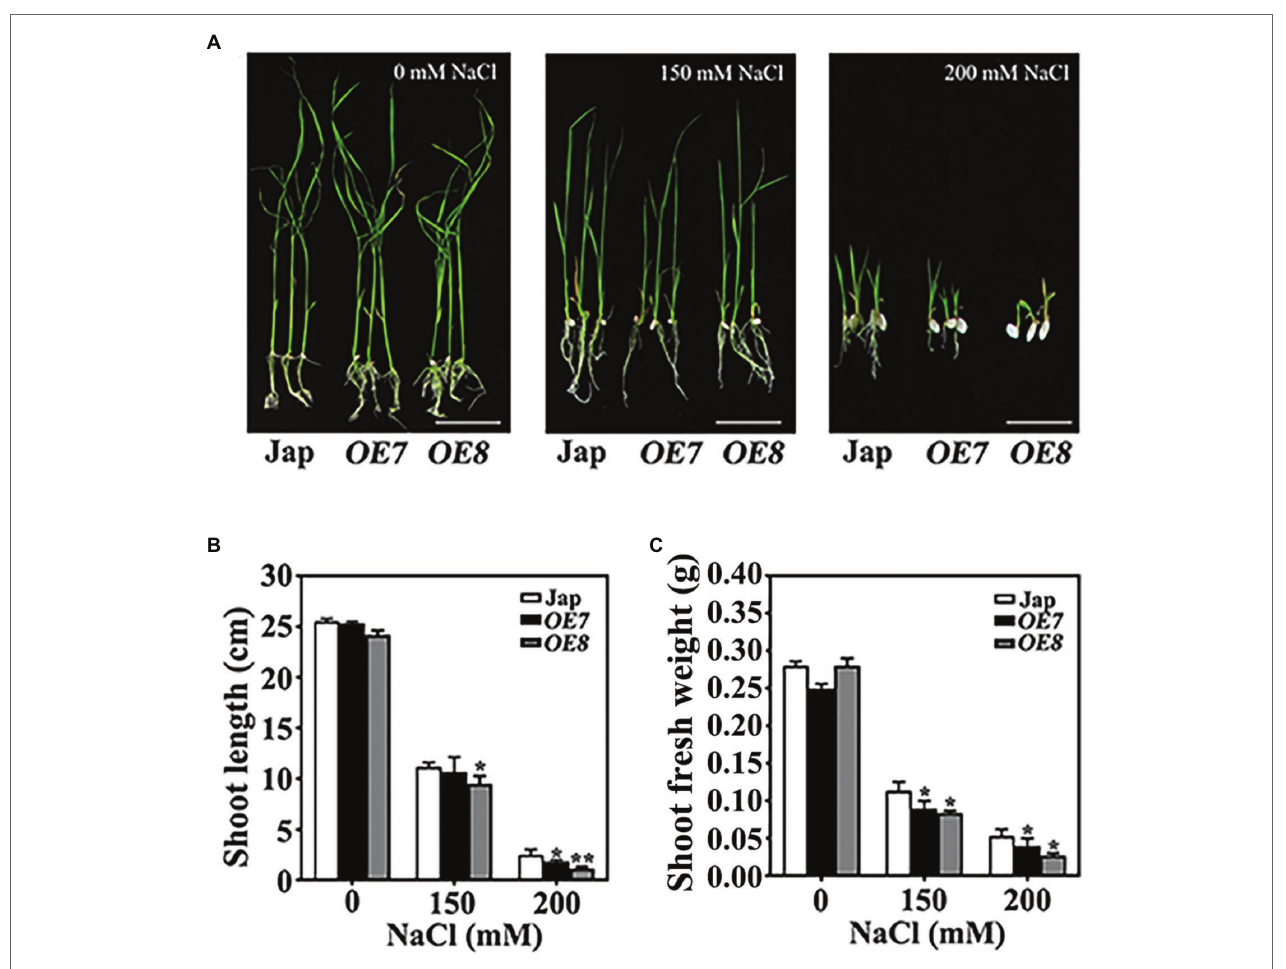
FIGURE 2 | OsWAK112 overexpression confers salt hypersensitivity in rice. (A) The performance of OsWAK112OE seedlings compared with Jap on media containing the indicated concentrations of NaCl. Scale bar = 2 cm. The shoot lengths (B) and fresh shoot weights (C) of 10-day-old seedlings were analyzed. The experiments were repeated three times. Each data point represents the mean ± SE ( n ≥ 10). Asterisks indicate a difference relative to Jap (Student’s t -test, * p < 0.05 and ** p < 0.01) in (B,C)